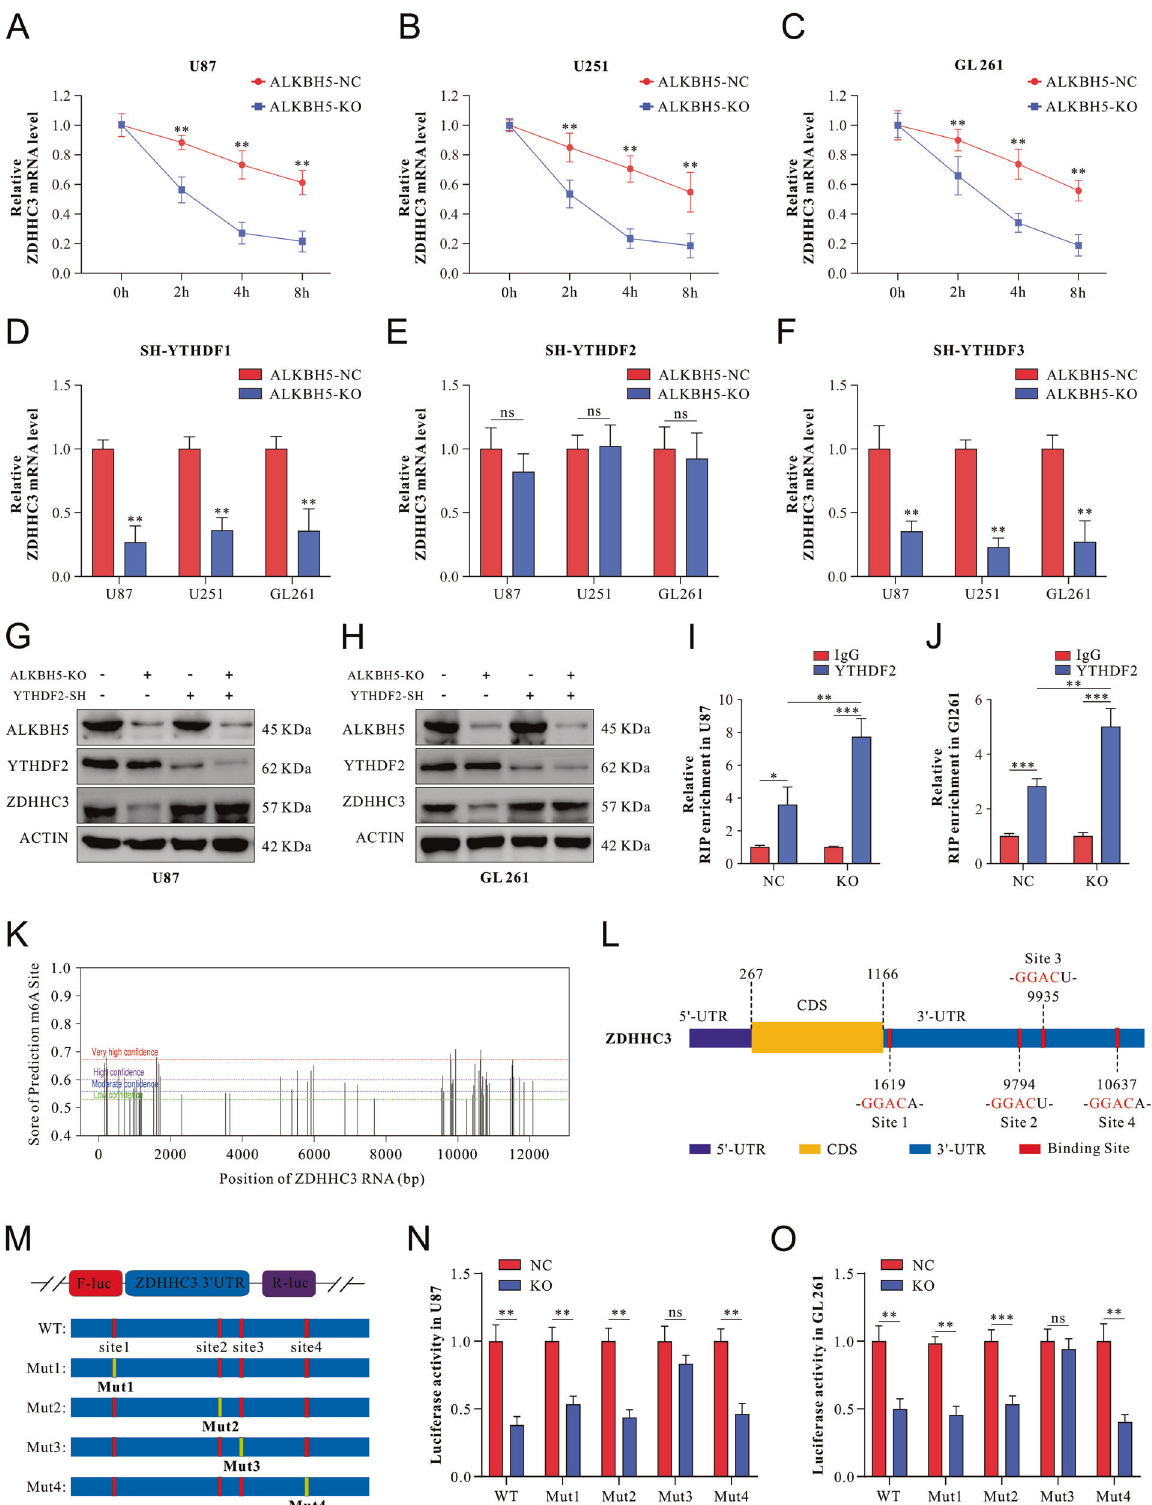
stabilizes ZDHHC3 mRNA by reducing the binding between ZDHHC3 mRNA and YTHDF2, followed by an increase in ZDHHC3 mRNA level. In addition, our data veri fi ed that both ALKBH5